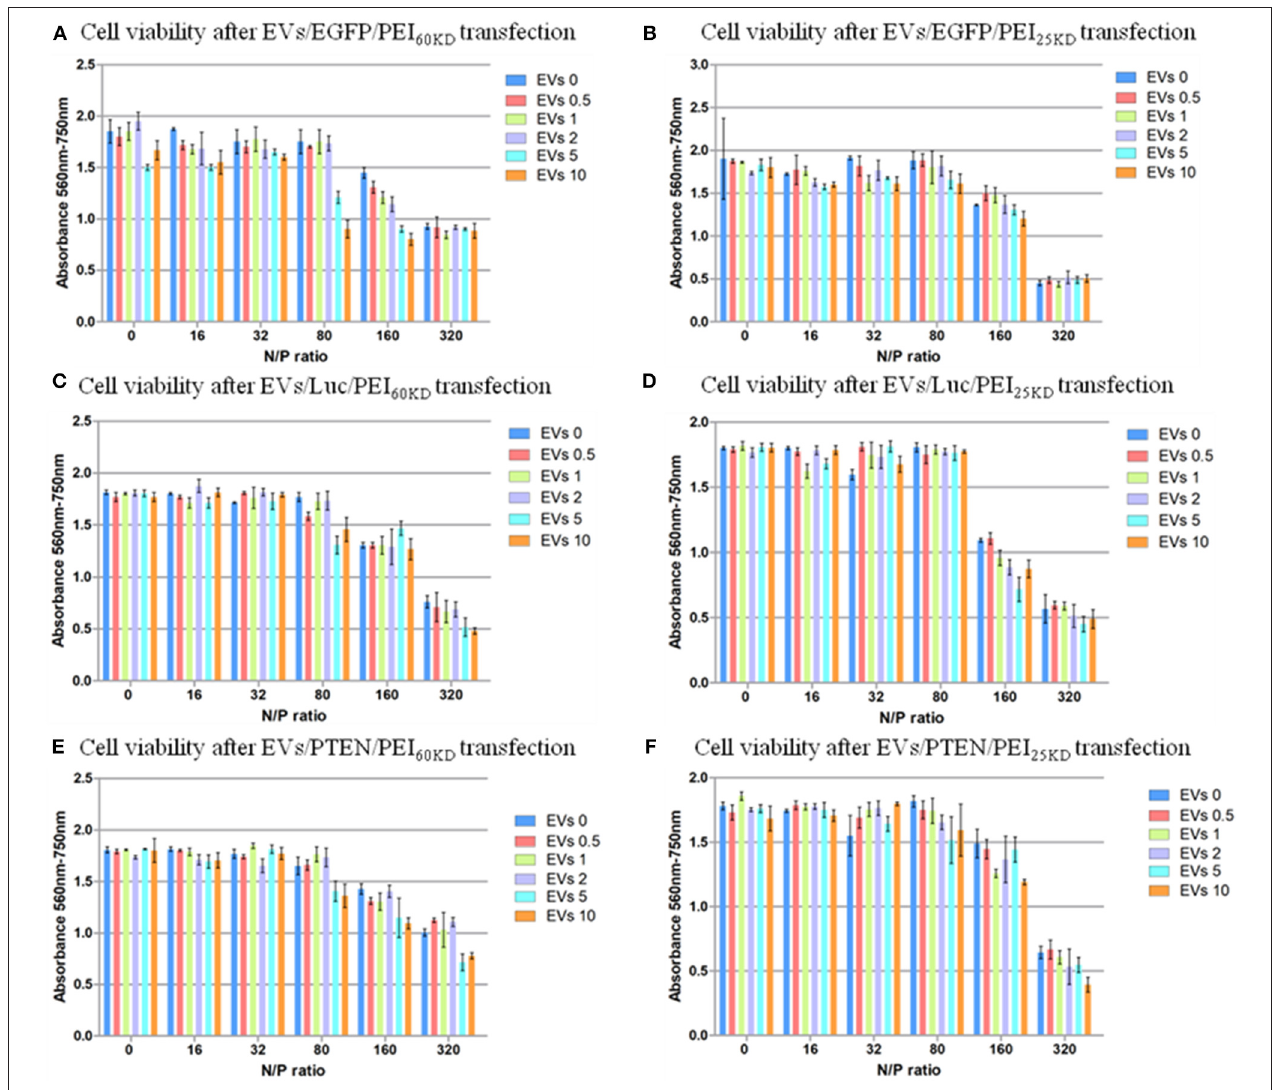
FIGURE 6 | Cell viability of HEK293T cells transfected with plasmid EGFP using (A) PEI 60kD and (B) PEI 25kD ; Cell viability of HEK293T cells transfected with plasmid ELuc using (C) PEI 60kD and (D) PEI 25kD ; Cell viability of HEK293T cells transfected with plasmid EpTEN using (E) PEI 60kD and (F) PEI 25kD , determined by MTT assay, at a post transfection time of 48h for different N/P ratios. EV solution of different volume (0, 0.5, 1, 2, 5, and 10 µ L) was added into each well of the 96-well plate. The protein concentration in EV solution was 3 ng/ µ L − 1